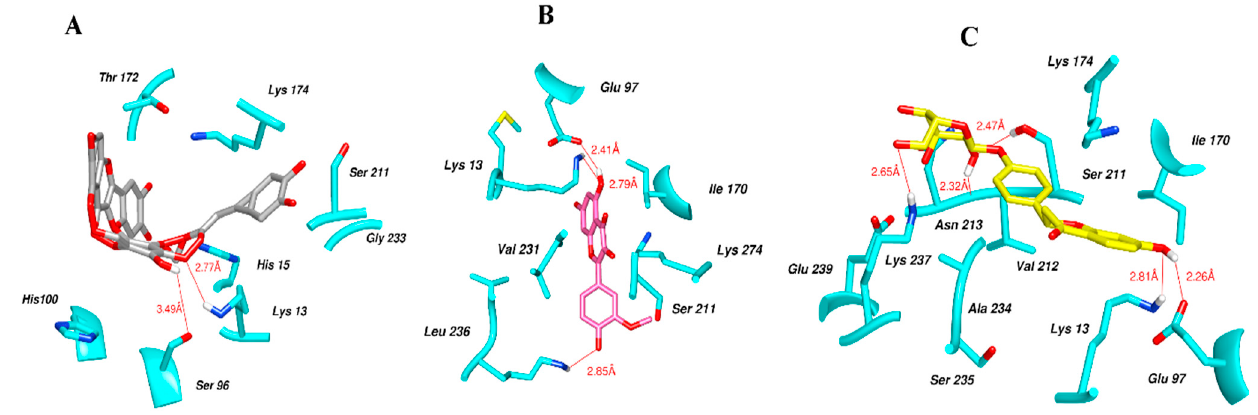
Figure 6. Docking interactions between ( A ) quercetagetin-7- O -(6- O -caffeoyl- β - D -glucopyranoside) 2, ( B ) isorhamnetin, and ( C ) liquiritin and the RmTIM protein. The center part of these subfigures represent the ligand surrounded by the interacting amino acids.